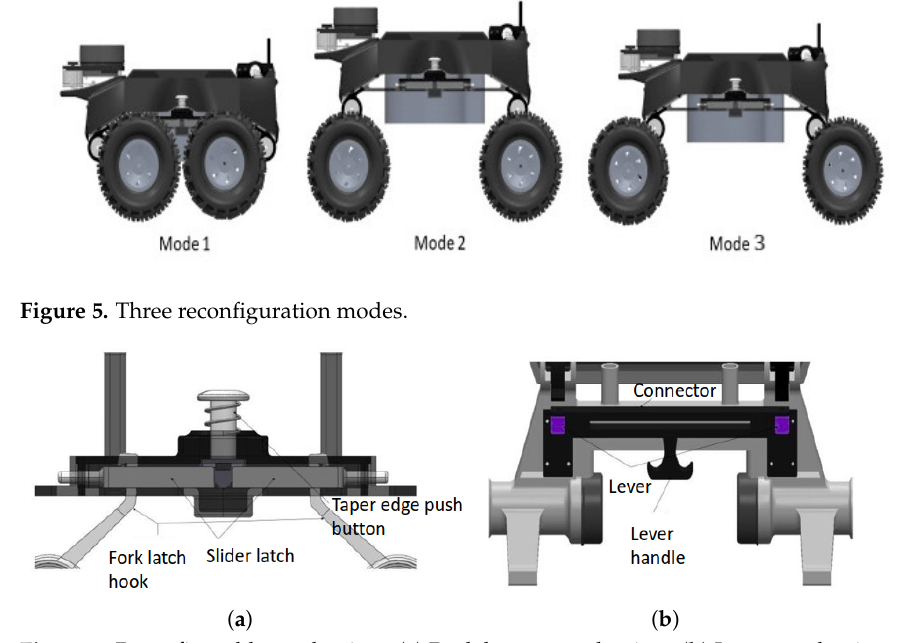
Figure 6. Reconfigurable mechanism. ( a ) Push button mechanism; ( b ) Lever